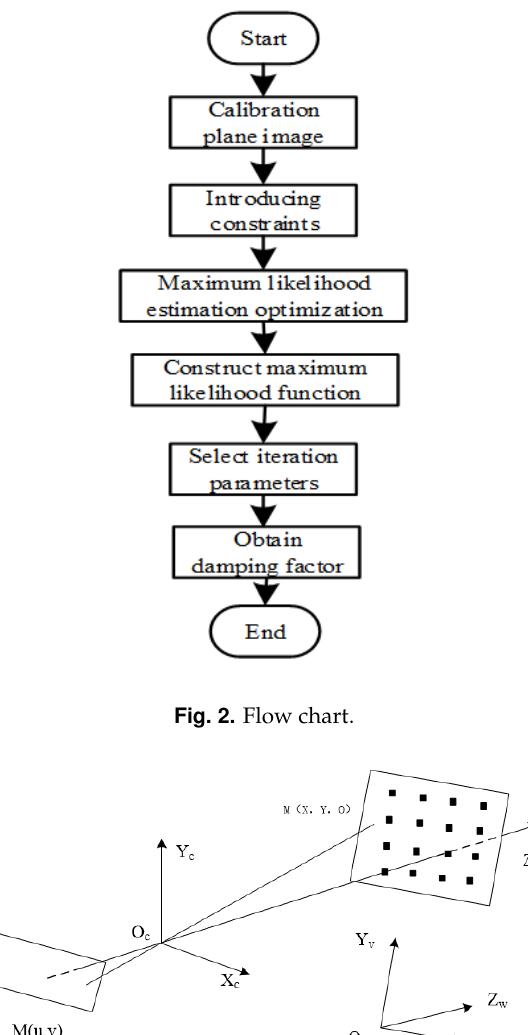
Fig. 3. Coordinate